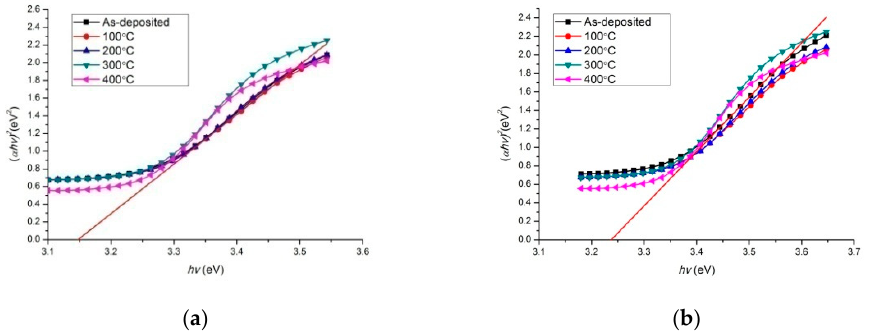
Figure 8. The relation curve between ( α hv ) 2 and hv of two annealed film systems: ( a ) ZnO(Cu); ( b ) ZnO(Ti/Cu).